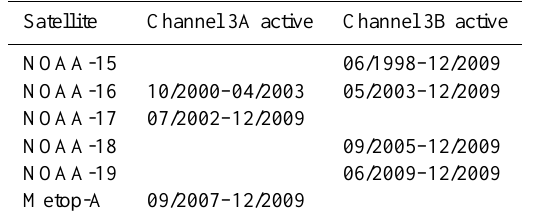
Table 2. Channel 3A and 3B operations for the AVHRR/3 instru- ments during